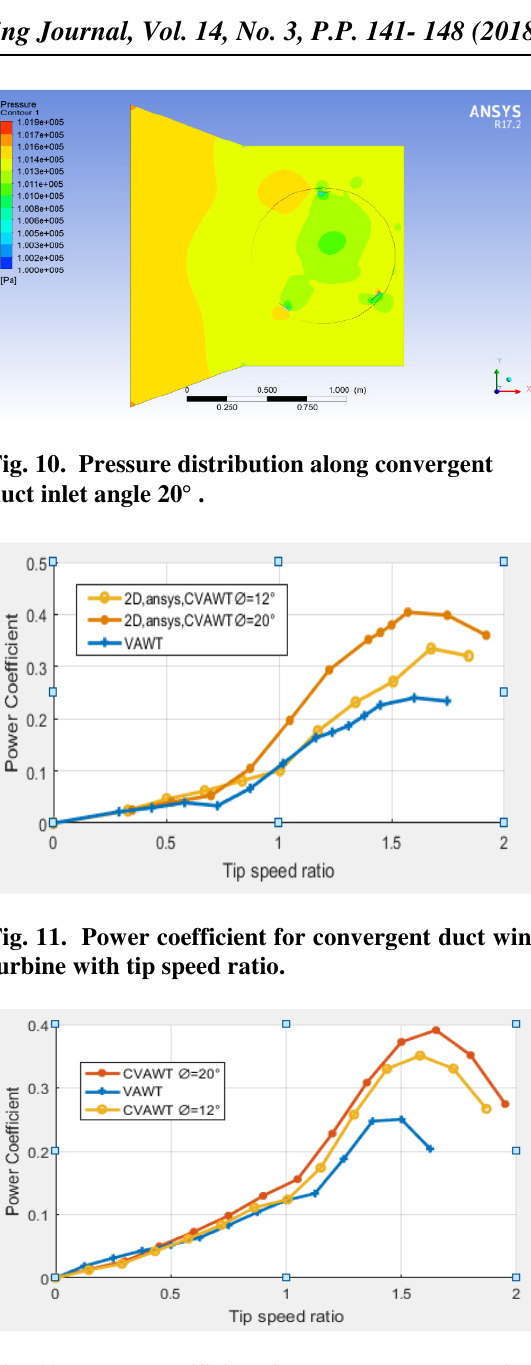
Fig. 12. Power coefficient for convergent duct wind turbine with tip speed ratio.